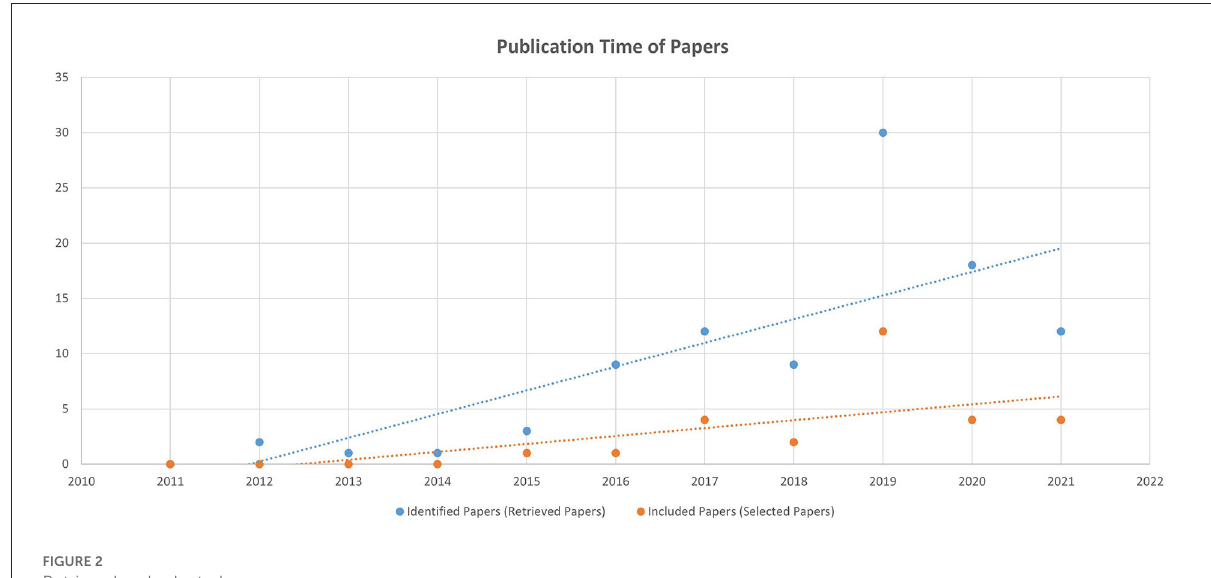
FIGURE2 Retrieved and selected